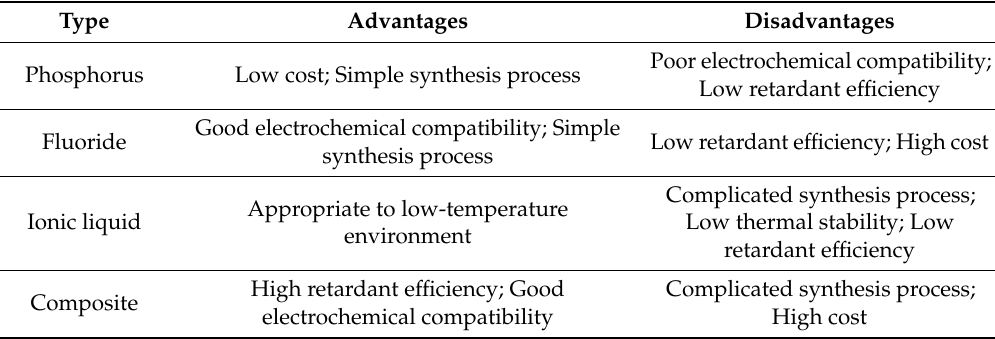
Table 2. The comparison of several typical fire-retardant electrolyte additives.